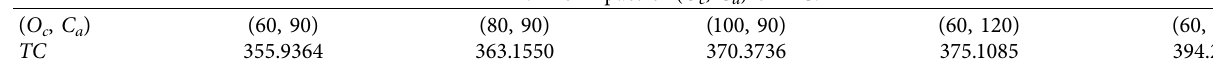
Table 2: The impact of ( O